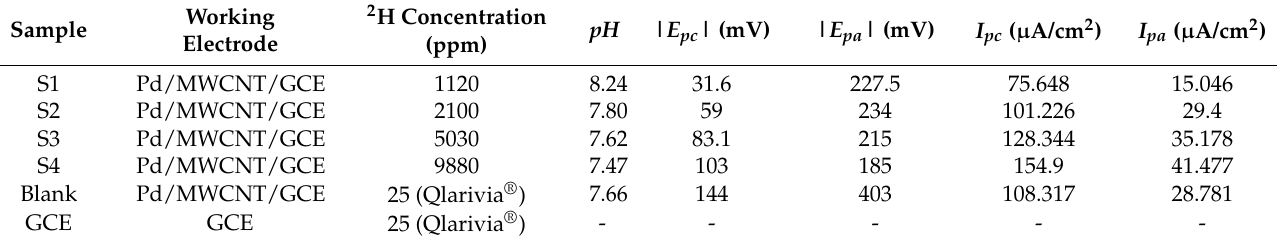
Table 1. Main characteristics of the investigated